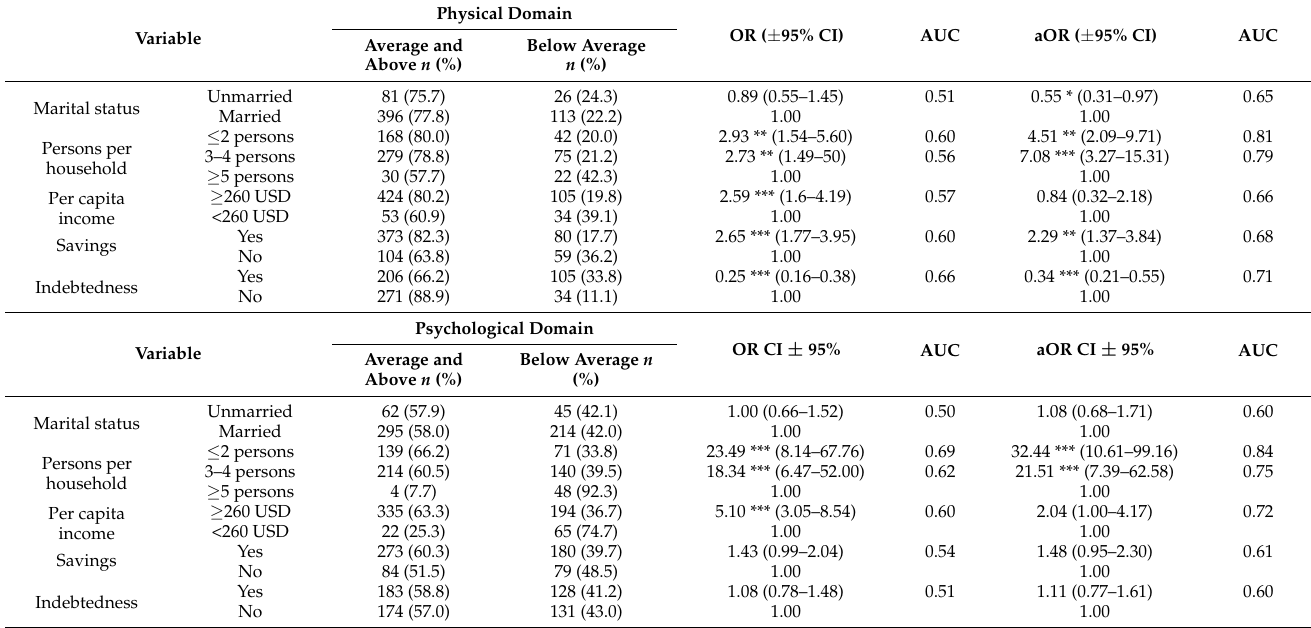
Table 5. Health-related quality of life in the physical and psychological domains and socioeconomic status of private entrepreneurs from Wrocław ( N = 616).